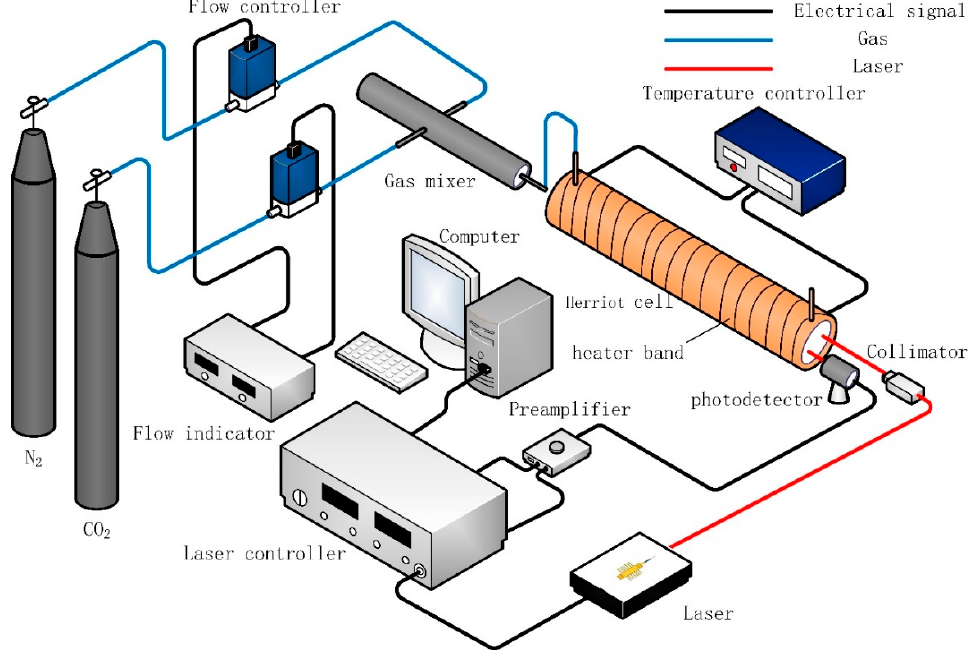
Figure 2. Schematic diagram of the experimental setup.